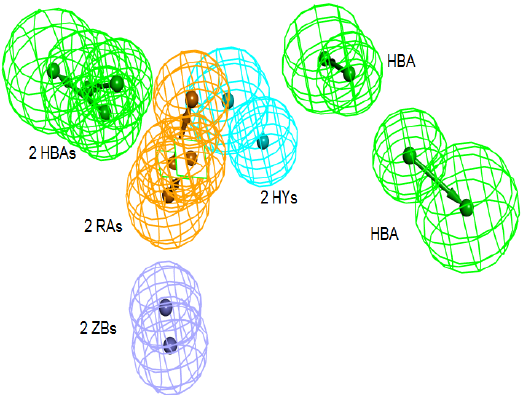
Figure 5. Superimposition of pharm-3A over Pharm-B showing the degree of similarity between the two pharmacophores of RMSD value of 2.52. HY; hydrophobic, RA; ring aromatic, HBA; hydrogen bond acceptor, ZB; zinc binder.